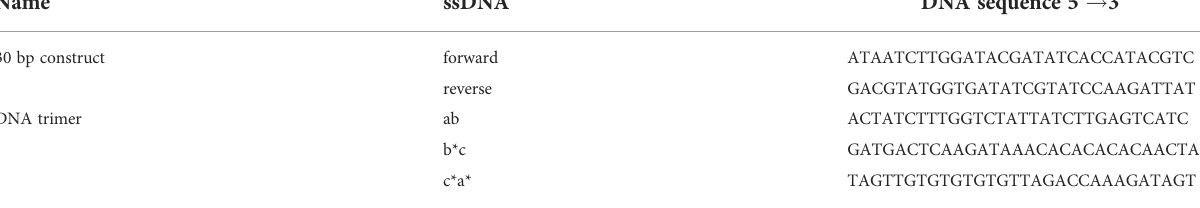
TABLE 1 Oligonucleotide sequences of DNA constructs.